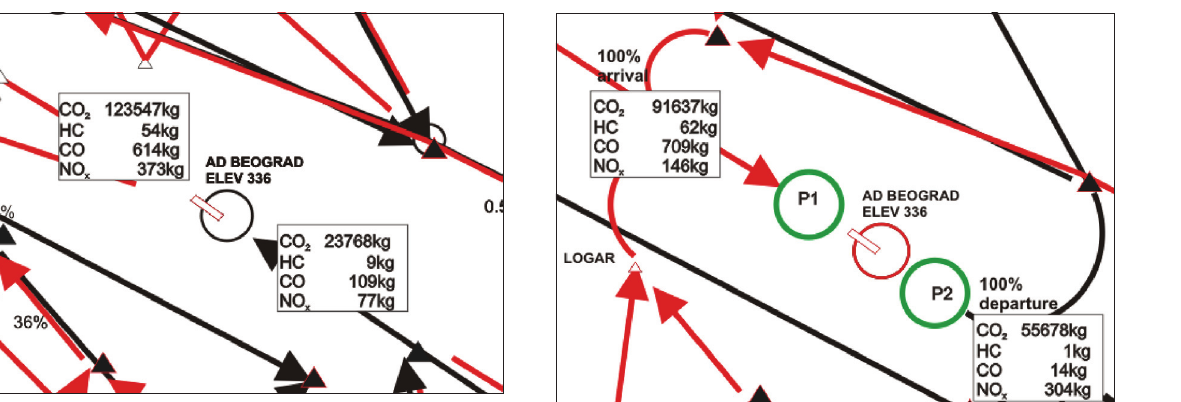
Fig. 9. The distribution of total emissions during arrival and departure on an average summer day of 2009